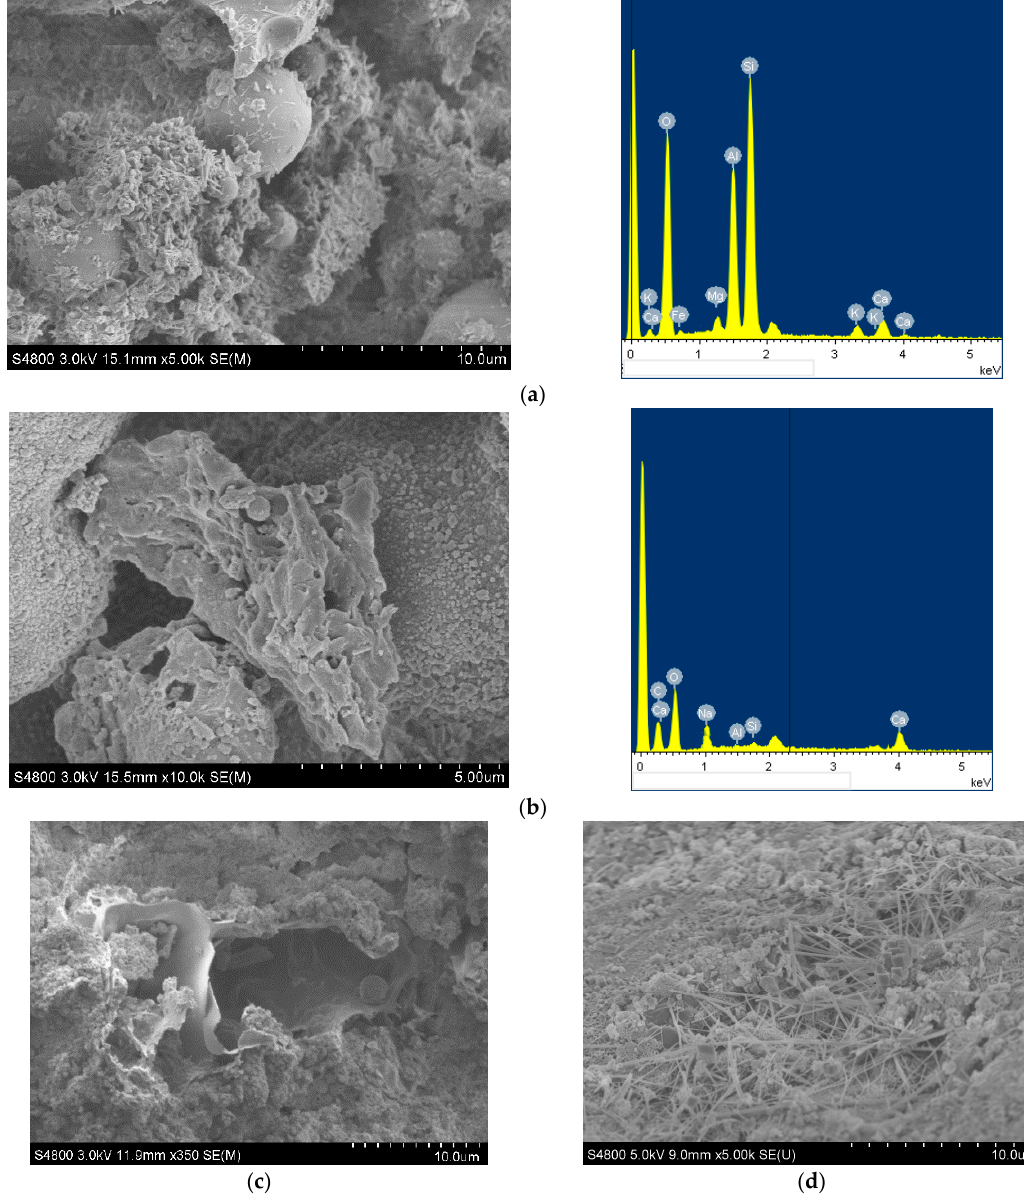
Figure 8. SEM images. ( a ) Fly ash; ( b ) SAP; ( c ) hole formed by dry SAP; ( d ) AFt and Ca(OH) 2.